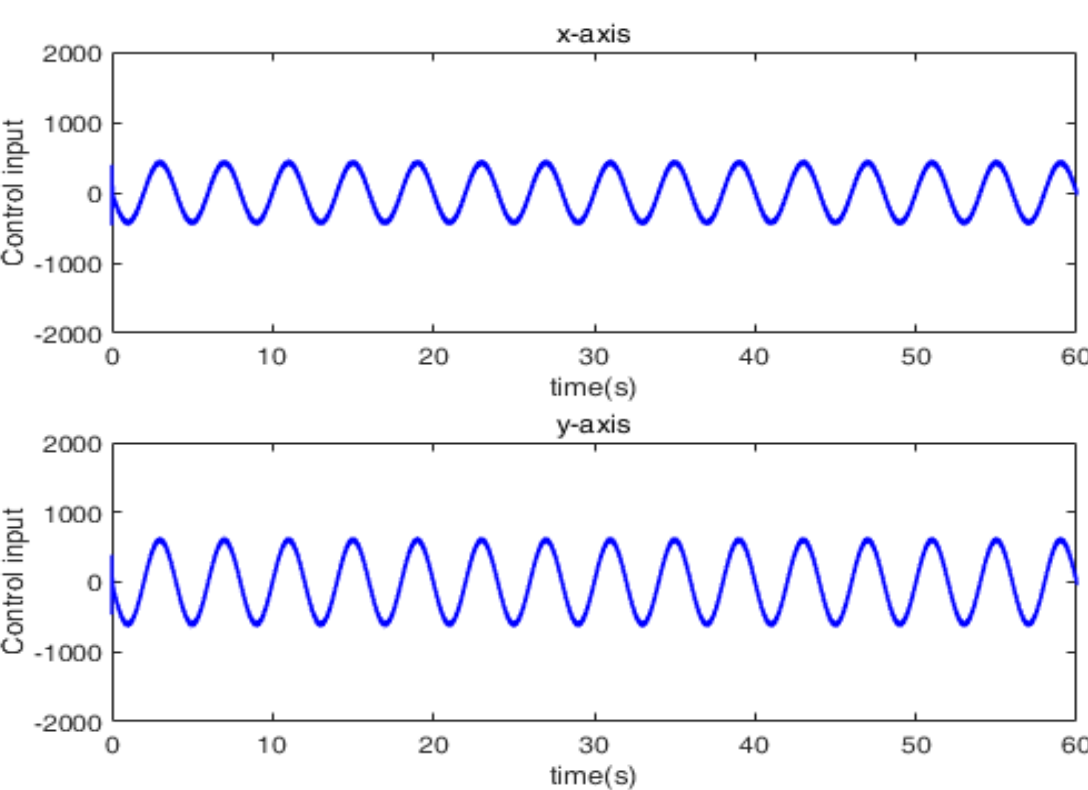
Figure 10. Control input under NFTSMC ‐ GRFNN.